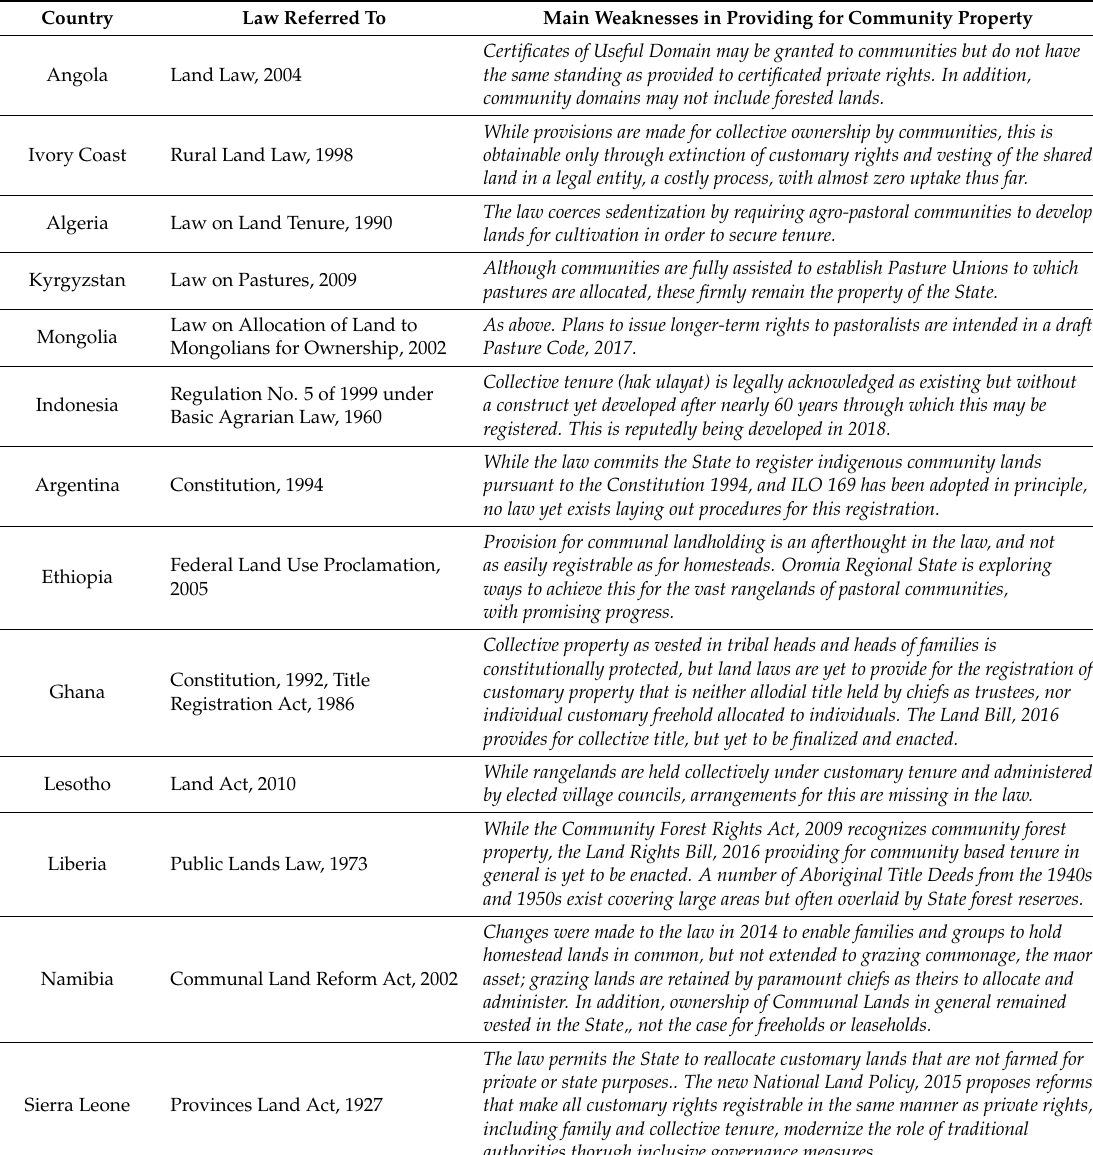
Table 4. Weaknesses in Legal Provision for Community